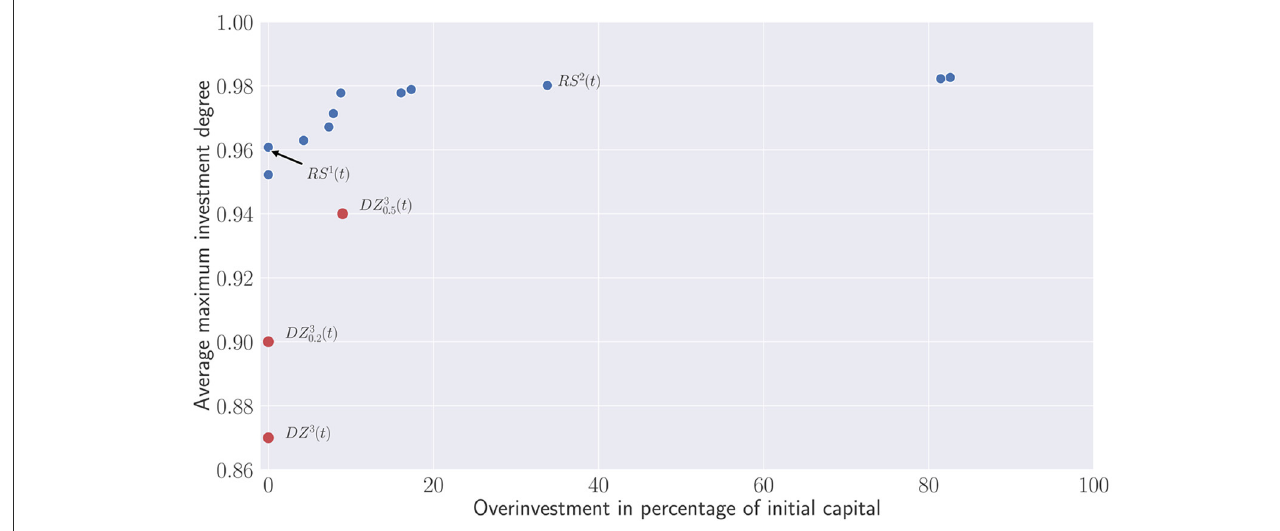
FIGURE13 Comparison between de Zwart’s variants and the obtained Pareto